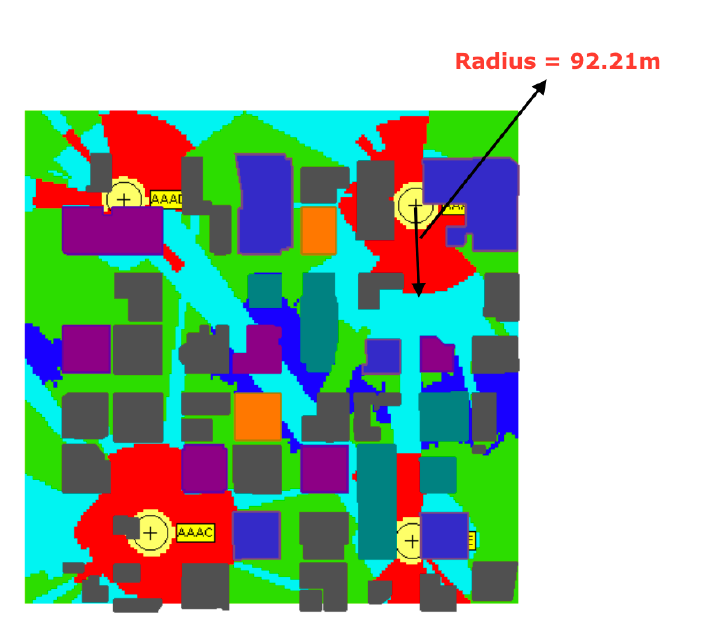
Figure 12. Heuristic site location for outdoor with MIMO